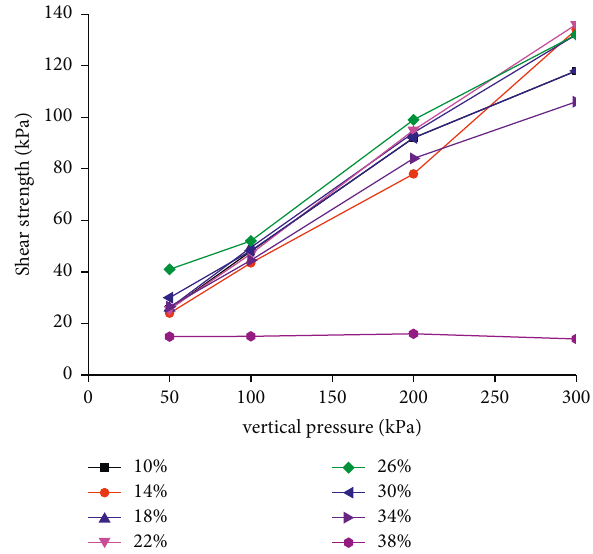
Figure 5: Variation of shear strength of loess samples with different microbial cementation solution ratios under vertical